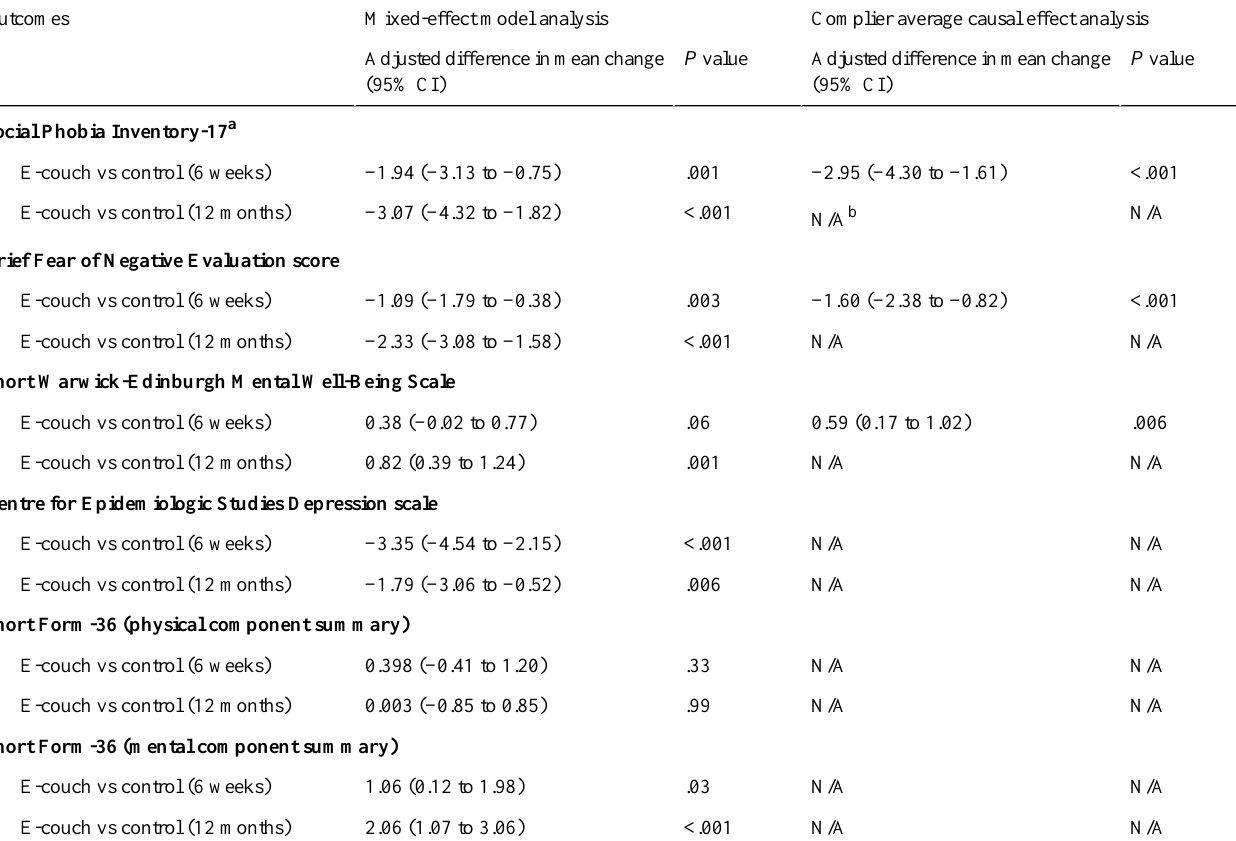
Table 2. Adjusted estimates from mixed-effect model for each outcome at 6 weeks and 12 months and estimates from the complier average causal effect analysis at 6